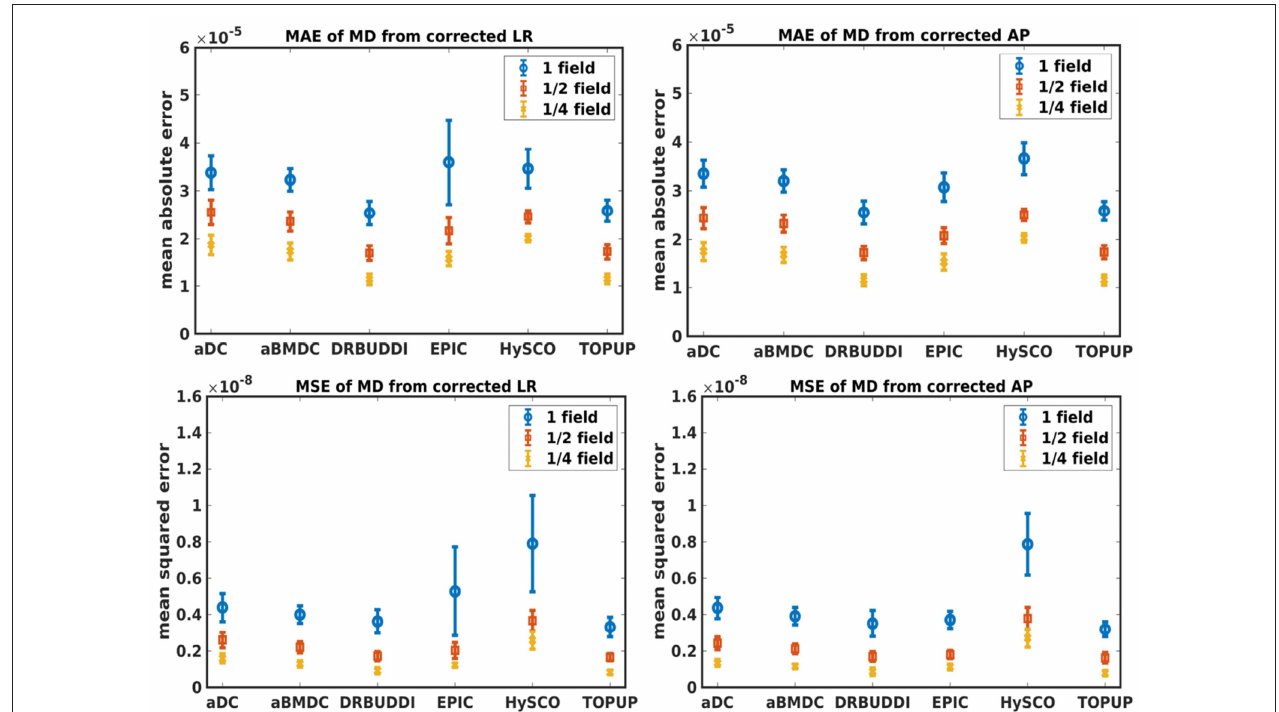
FIGURE 7 | MAE (Top) and MSE (Bottom) of MD for five simulated HCP subjects using the six methods. The error bars represent standard deviation over subjects. Correction was carried out for LRRL (Left) and APPA (Right) pairs, respectively. Three levels of susceptibility distortion were simulated.